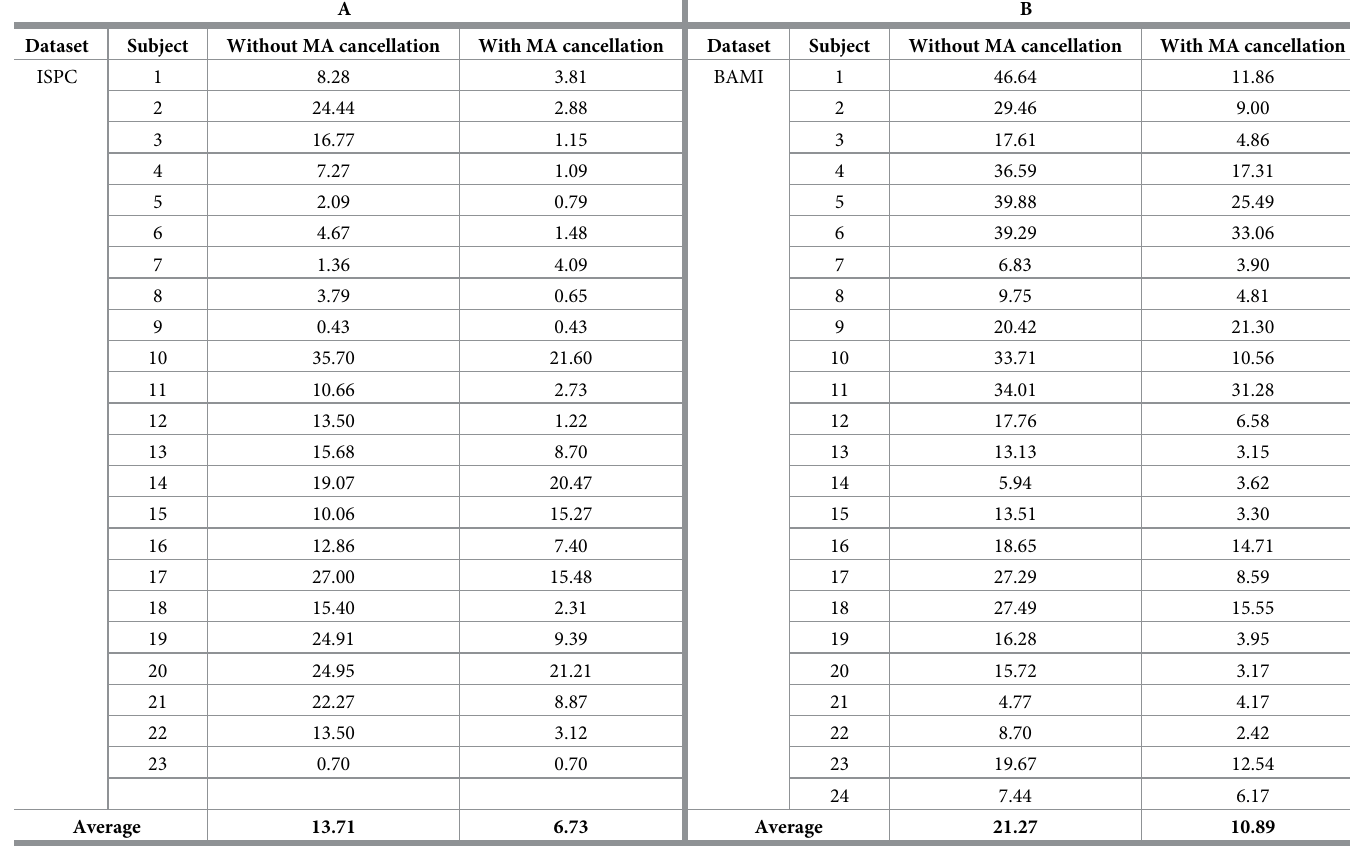
Table 1. Comparison of the HR estimation results obtained with and without MA cancellation for the ISPC ( n = 23) and BAMI ( n = 24) datasets. The performance was evaluated on the basis of the mean absolute error (MAE).